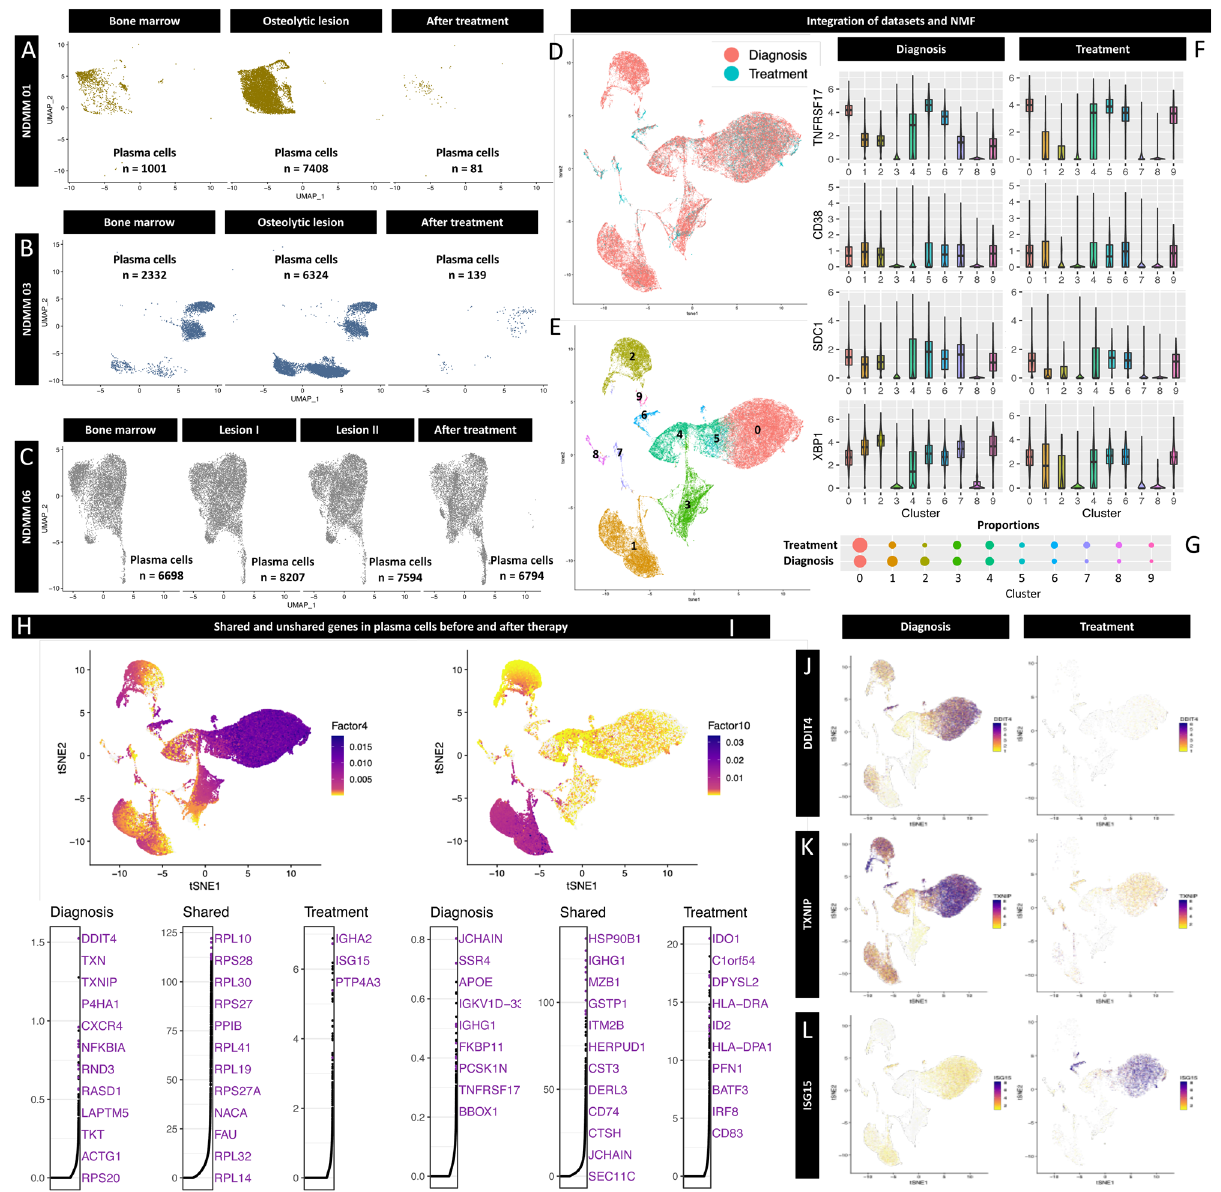
Fig. 7 Characteriztion of measurable residual disease on a single cell level in longitudinal samples. Uniform manifold approximation and projection (UMAP) plots and number of sequenced malignant plasma cells (PC) split by the origin of PC for patients NDMM01 A and NDMM03 B after 4 cycles lenalidomide, bortezomib and dexamethasone (RVD) as well as NDMM06 C after 4 cycles daratumumab-RVD. While NDMM01 and NDMM03 were in complete remission (CR) with measurable residual disease (MRD), NDMM06 was in partial remission (PR). Linked inference of Genomic Experimental Relationships (LIGER) was used for integrative non-negative matrix factorization to identify shared and unshared genes in longitudinal samples before and after treatment. Cells were visualized based on treatment situation ( D , diagnosis (red) versus treatment (green)) and the identi fi ed clusters E . The majority of sequenced cells after therapy represented PC as shown by expression of common PC markers with median expression represented by horizontal lines, interquartile range by boxes and 95% con fi dence interval by whiskers in the respective box plots F . Proportions of the identi fi ed clusters before and after therapy are visualized by dotplots in G . Using LIGER, shared and unshared genes between diagnosis and after treatment were visualized based on the identi fi ed factors H , I . DDIT4 J and TXNIP K were downregulated in the majority of PC after therapy compared to primary diagnosis. Both genes are involved in mediating cellular response to steroid exposure 34 . Besides genes encoding HLA Class II molecules, ISG15 was signi fi cantly upregulated in PC after treatment and has been linked to car fi lzomib-resistance in the past L 34 . Relative expression ranging from low in yellow, to high in